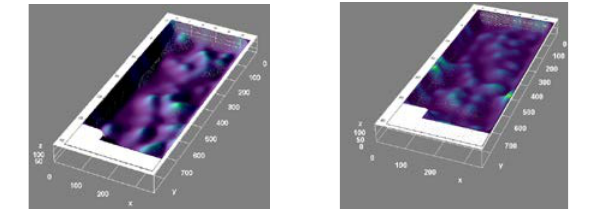
Figure 7. 3D surface plot 1961 Figure 8. 3D surface plot 2017